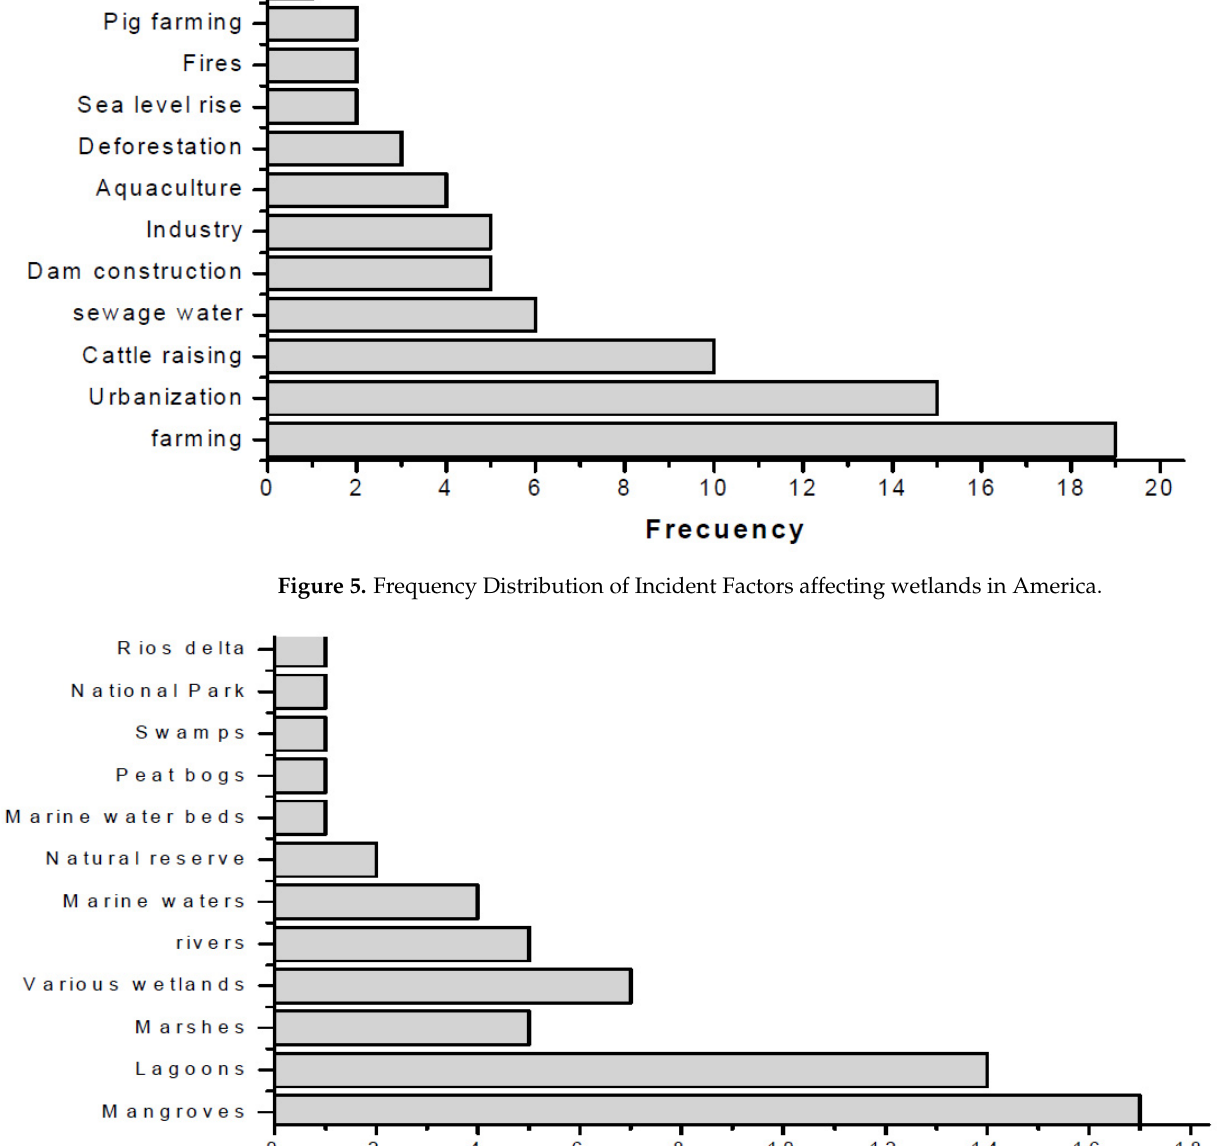
Figure 6. Frequency distribution of the type of wetland affected in America.